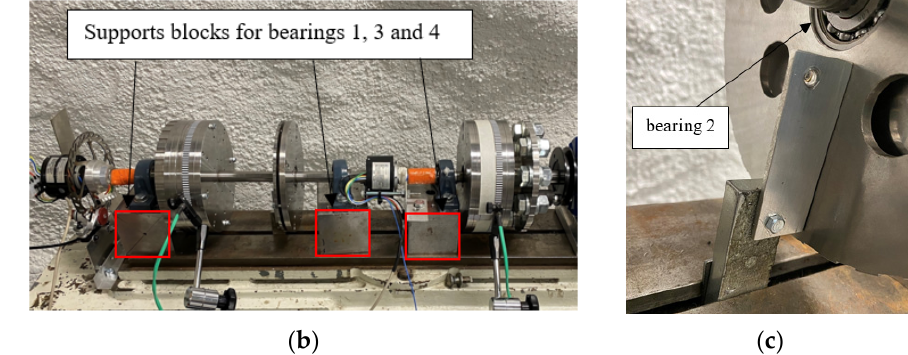
Figure 4. Setup view, ( a ) Detail view of flexible coupling, ( b ) Support blocks for bearings 1, 3, and 4, ( c ) Connection of support 2 to the base. Table 1. The main dimensions and material properties of the rotor system.